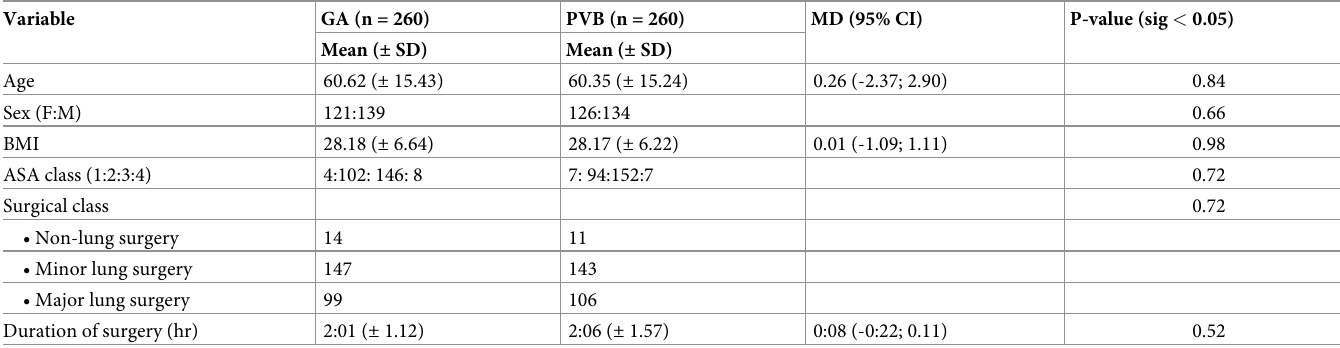
Table 1. Patient characteristics and surgical